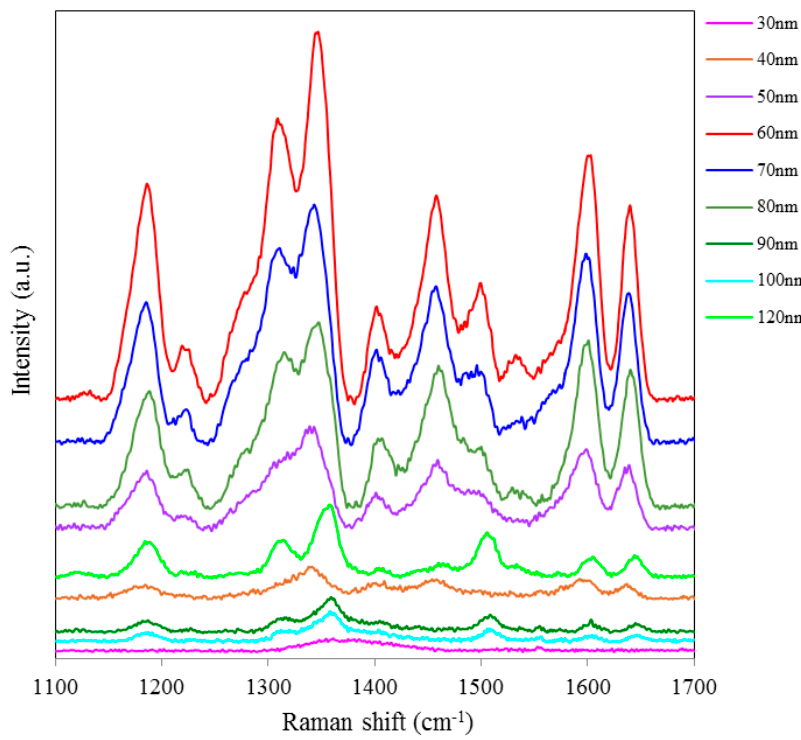
Figure 4. SERS spectra of 8 × 10 − 5 M solution of Rh6G dye adsorbed on the surfaces of 55 nm nanoporous substrate coated with 30, 40, 50, 60, 70, 80, 90, 100 and 120 nm gold films, measured with 3 s integration time.